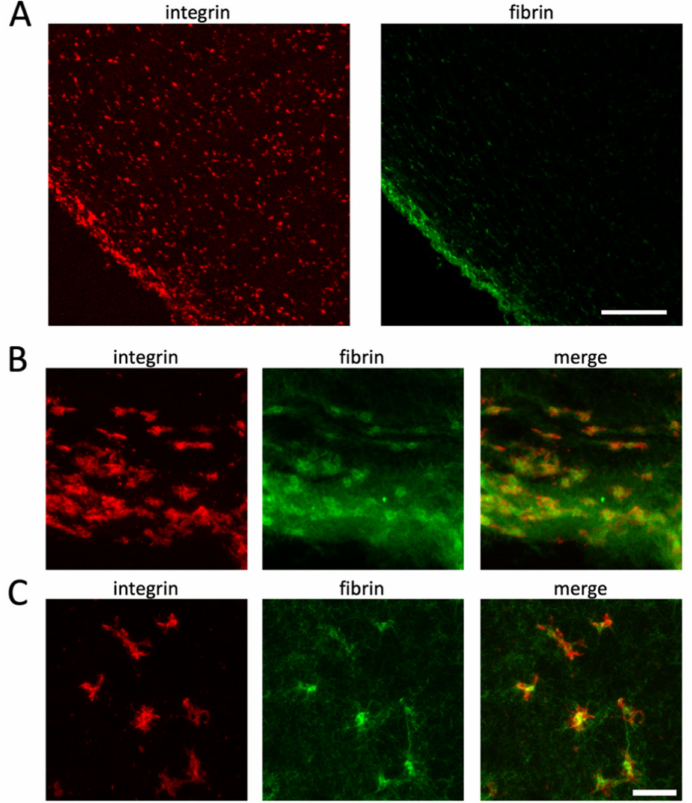
Figure 5. Platelets accumulate in the clot periphery after clot contraction under isometric tension. Alexa 488-labeled fibrinogen was added to PRP before the induction of clot formation in tubes containing two holders (see Supplementary Figure S1B). Clots were fixed after 3 h of retraction at 37 ◦ C, and sections were stained for α IIb integrins. Left image shows integrin staining (red), and right image shows fibrin fibers (green); scale bar, 100 µ m ( A ). Higher-resolution images show that platelets are more compact in the clot periphery ( B ) than in the clot center ( C ); scale bar, 10 µ